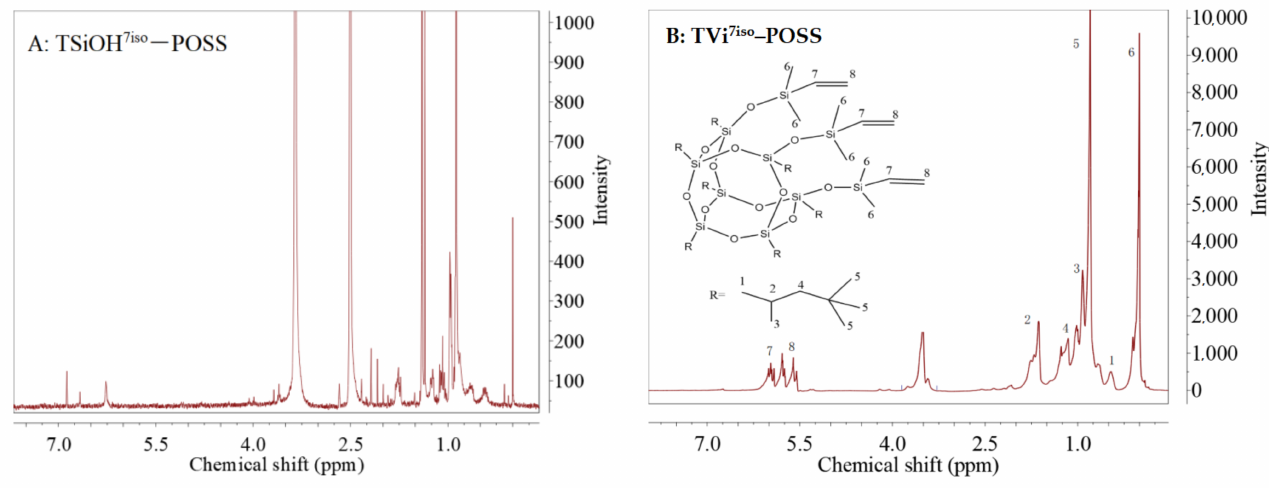
Figure 2. 1 H–NMR spectra of TSiOH 7iso –POSS ( A ) and TVi 7iso –POSS ( B ).